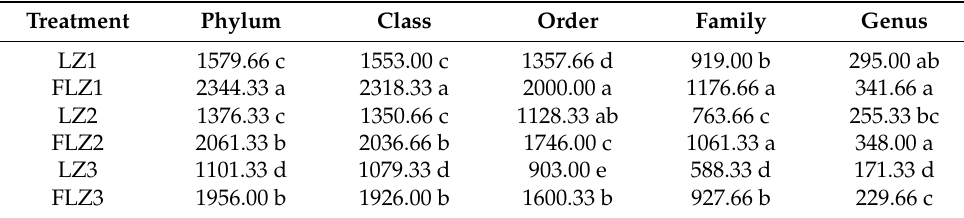
Table 3. Statistical table of classification and classification of status identification results by OTU in different soil samples.